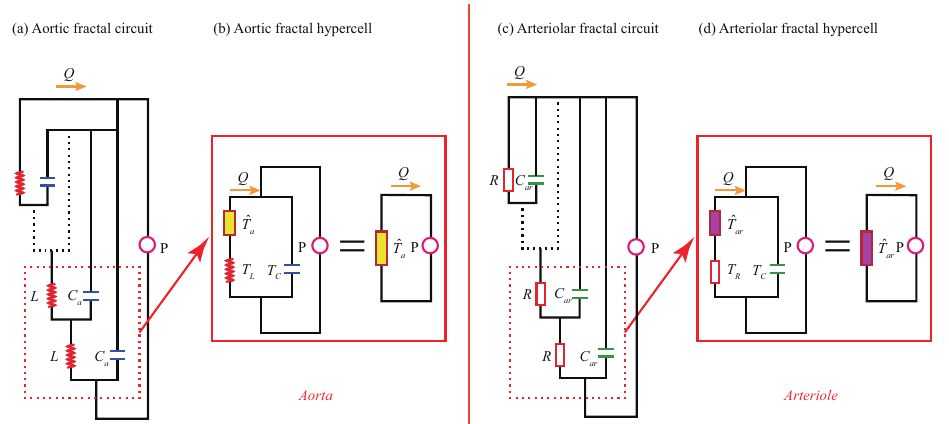
Figure 4. The fractal functional circuits (FFC) and fractal hypercells (FHC) of the aorta and arteriole: ( a , b ) the FFC and FHC of aorta, respectively; ( c , d ) the FFC and FHC of arteriole,